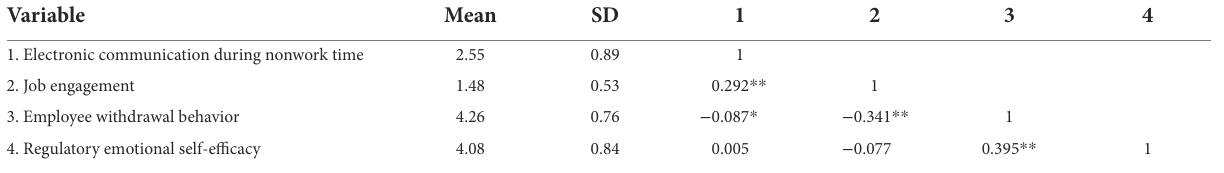
TABLE 1 Descriptive statistic and correlation analysis for each variable.